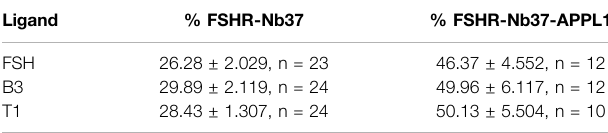
TABLE3| Co-localizationofFSHRendosomeswithNb37andAPPL1viaTIR-FM. Mean ± SE.